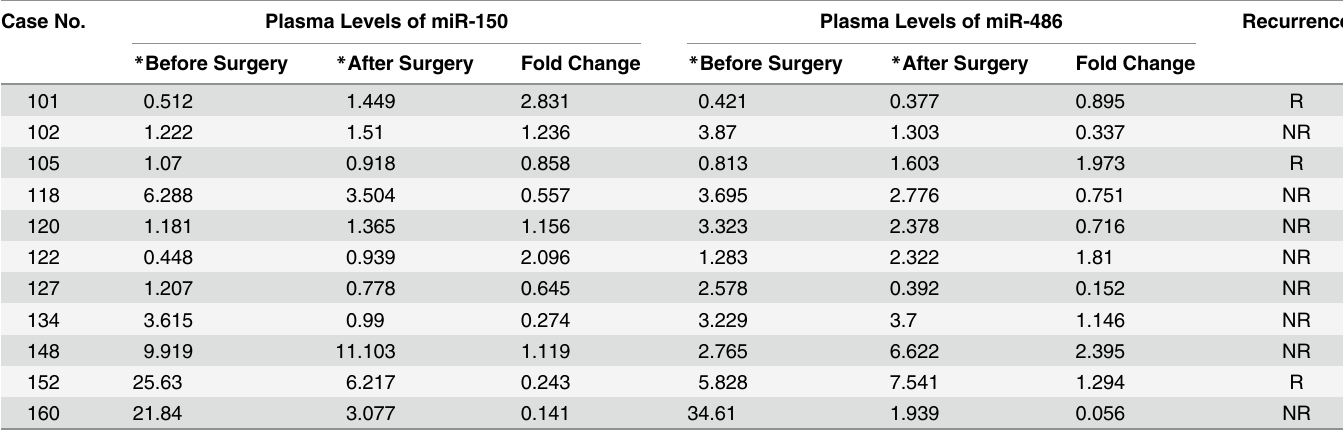
Table 2. Plasma miRNA level changes before and after surgery. Case